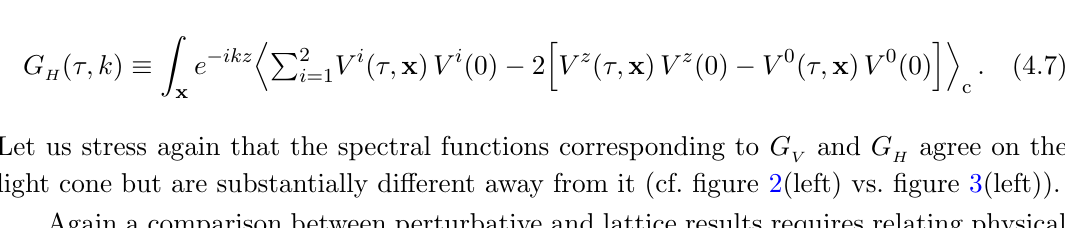
Figure 2 . Results for (cid:26) to eq. (4.6). LPM LO refers to results from sections 3.2 and 3.3, employing the two scale